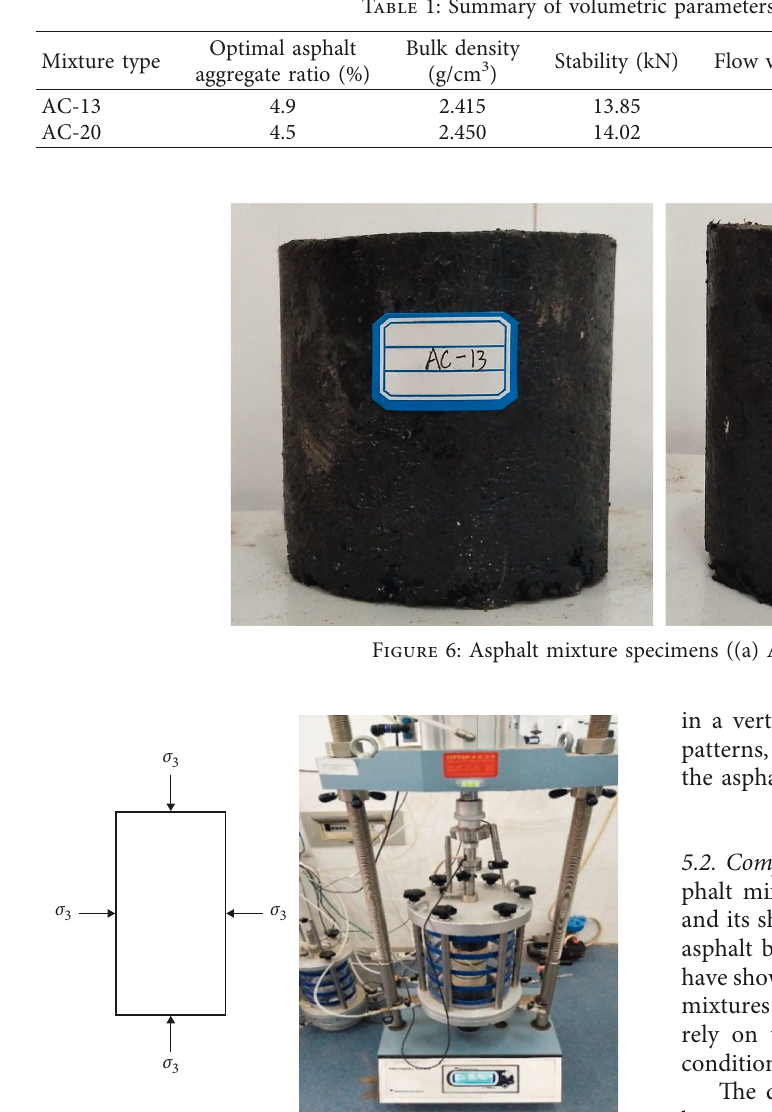
Figure 7: Triaxial test mode and